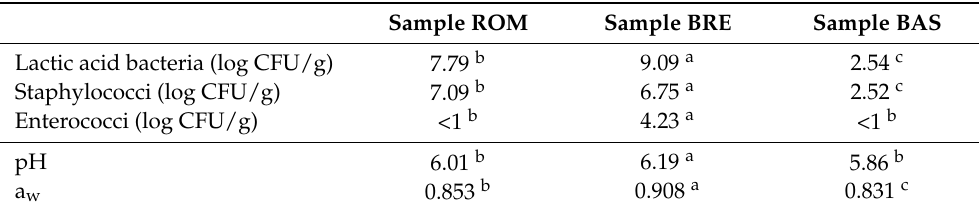
Table 3. Microbiological counts and chemico-physical features of the spontaneously fermented sausages at the end of ripening.